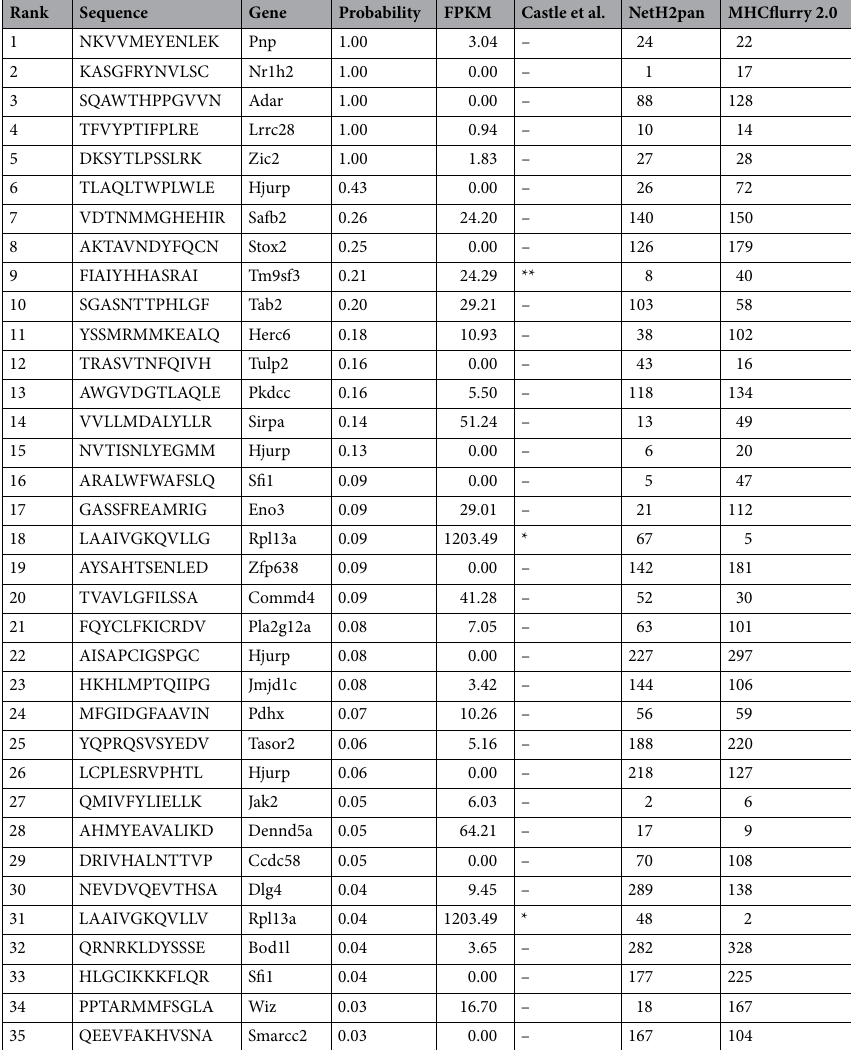
Table 3. Putative neoantigens, shown by sequence and gene symbol, ranked by scores for the H-2K b restricted B16 melanoma model. The gene expression is quantified as fragments per kilobase million. Neoantigens examined in Castle et al. 44 are classified by selection for validation (*) and reactivity (**). Ranked classification of the average scores of peptide sequences for a complete 12 mer sequence, considering epitope lengths between 8 and 12, given by NetH2pan and MHCflurry 2.0. The ranking of NetH2pan and MHCflurry 2.0 corresponds to binding affinity and presentation scores,